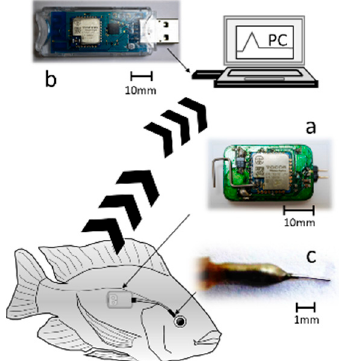
Figure 2. A schematic diagram of the wireless biosensor system. ( a ) The wireless transmitter: a self-made transmitter. It sends data by using radio waves. ( b ) The USB-type receiver: a self-made receiver that had been programmed to accept data from a particular transmitter. ( c ) Sensor implant site: interstitial fluid in the vicinity of the adventitia of the eyes of fish (EISF).